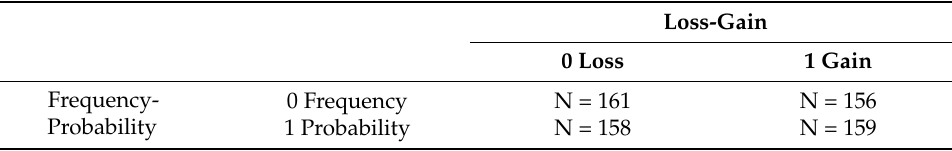
Table 1. The two dimensions (loss-gain, and frequency-probability) and how the sample was ran- domized across the different conditions. Loss-Gain 0 Loss 1 Gain Frequency- 0 Frequency N = 161 Probability 1